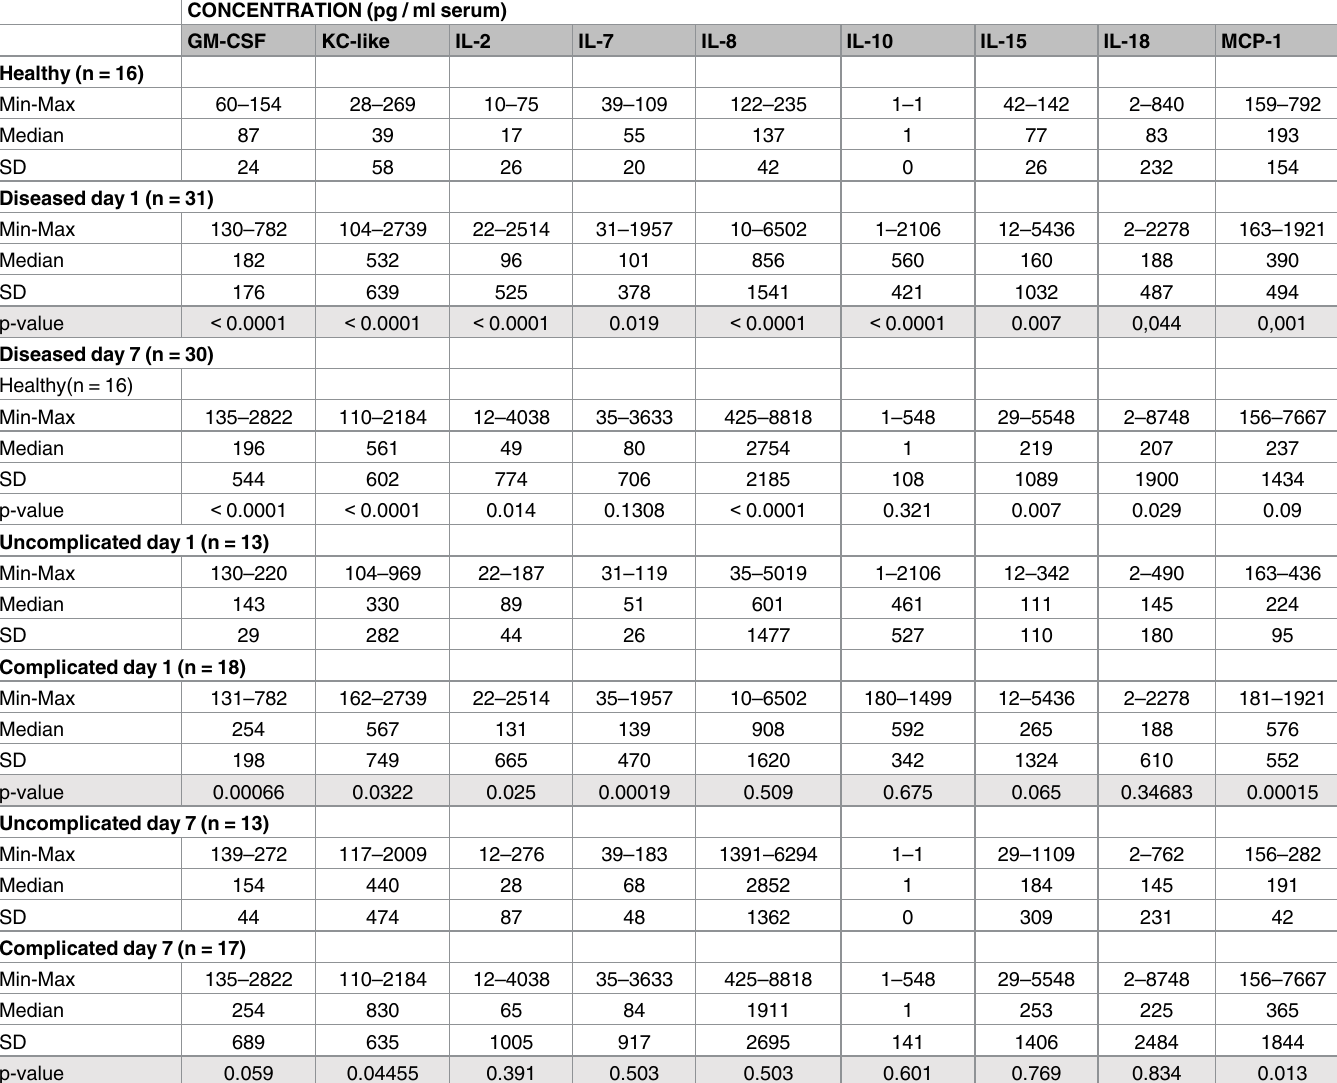
Table 2. Cytokine levels in different groups and subgroups. Cytokine concentrations (in pg/ml serum) for healthydogs (n = 16), B . canis - infected dogs on the day 1 (n = 31) and 7 (n = 30) and subset of uncomplicated (n = 13) and complicated groups (n = 18). 1 dog with complications died duringthe study. p- values for significantdifferencesare shown for each